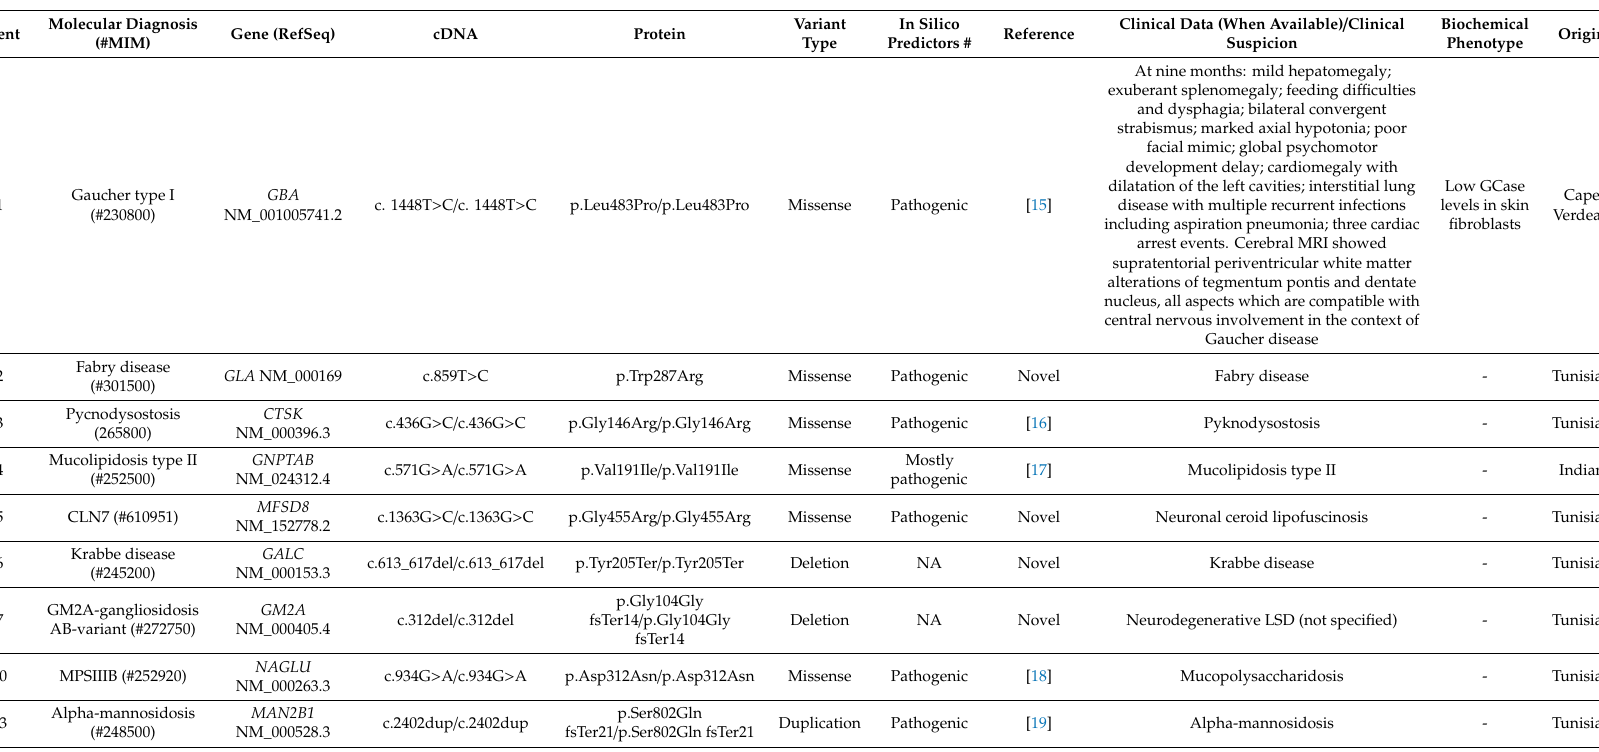
Table 1. Molecular genetic testing (MGT) results for patients shown to harbor LSD-causing pathogenic variants. Whenever clinical and / or biochemical data were available, that information was also